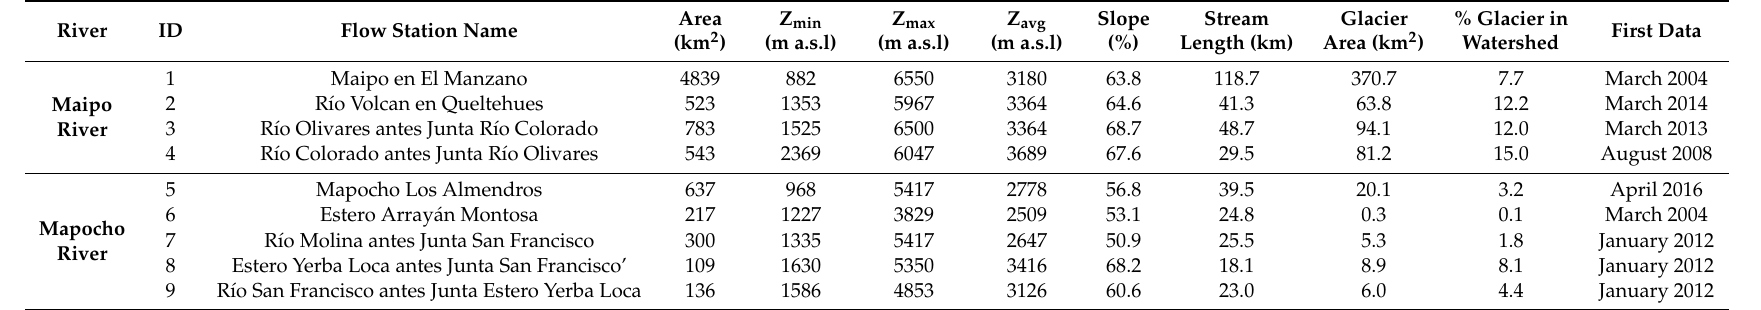
Table 1. Summary of morphological features and available information in the studied